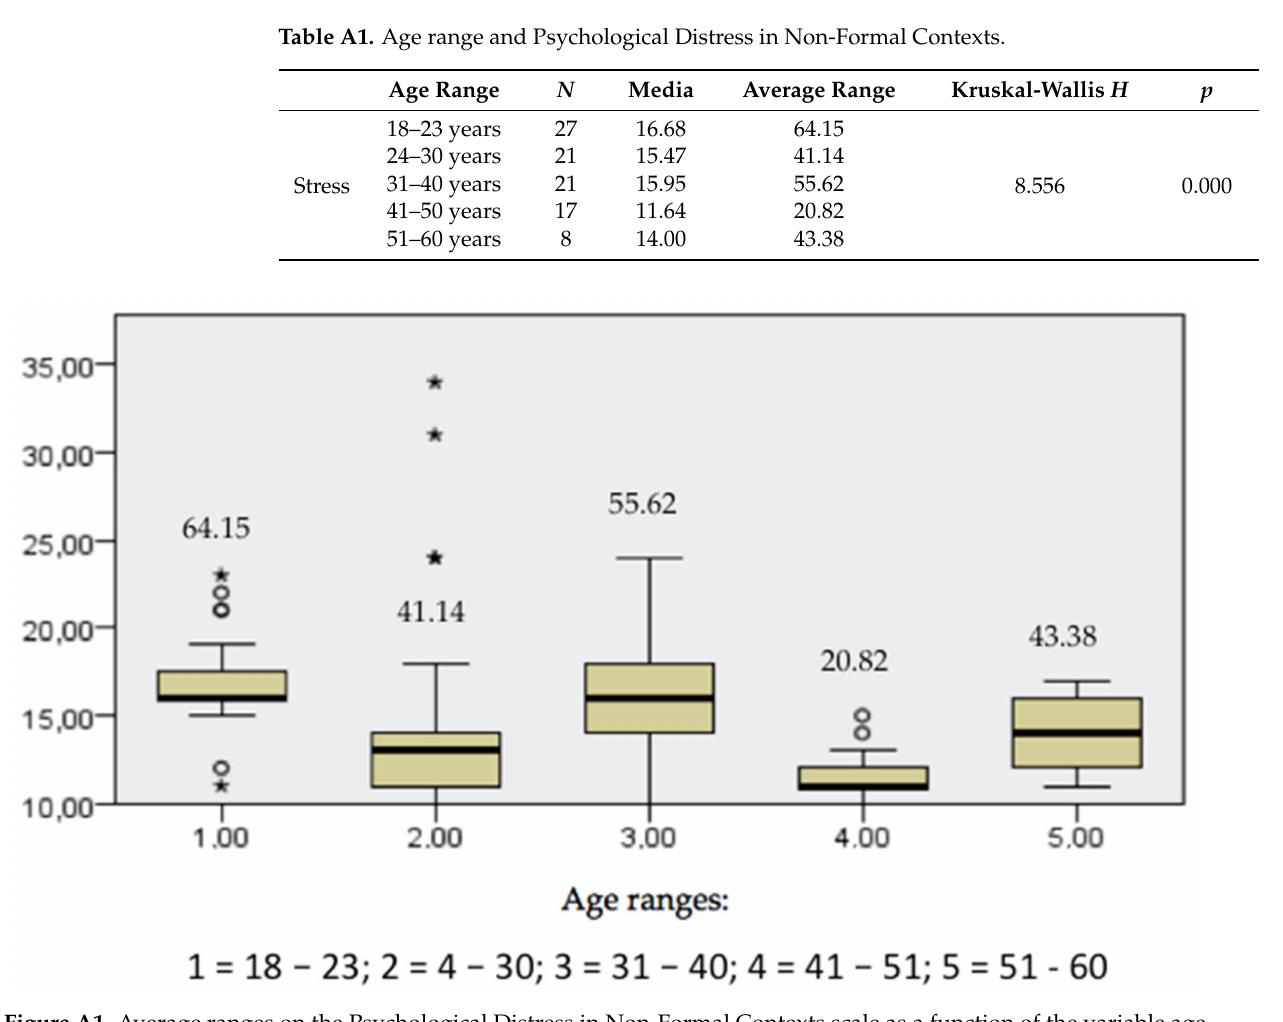
Figure A1. Average ranges on the Psychological Distress in Non-Formal Contexts scale as a function of the variable age range. * Values more than 3 interquartile ranges, ◦ Values more than 1.5 but less than 3 interquartile